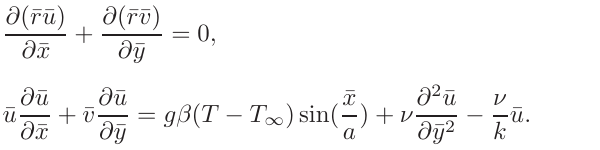
Here ¯ r (¯ x ) = a sin( ¯ x ) is the radial distance from the symmetrical axis of the a sphere, ¯ u and ¯ v are the components of velocity respectively in the ¯ x and ¯ y directions, k is the permeability of the porous medium, µ is the coefficient of fluid viscosity, ρ is the fluid density, ν = µ/ρ is the kinematic viscosity, β is